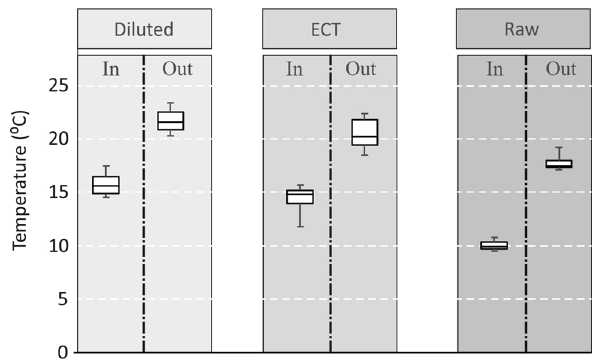
Fig. 4 Effects of the disinfection process on wastewater temperature